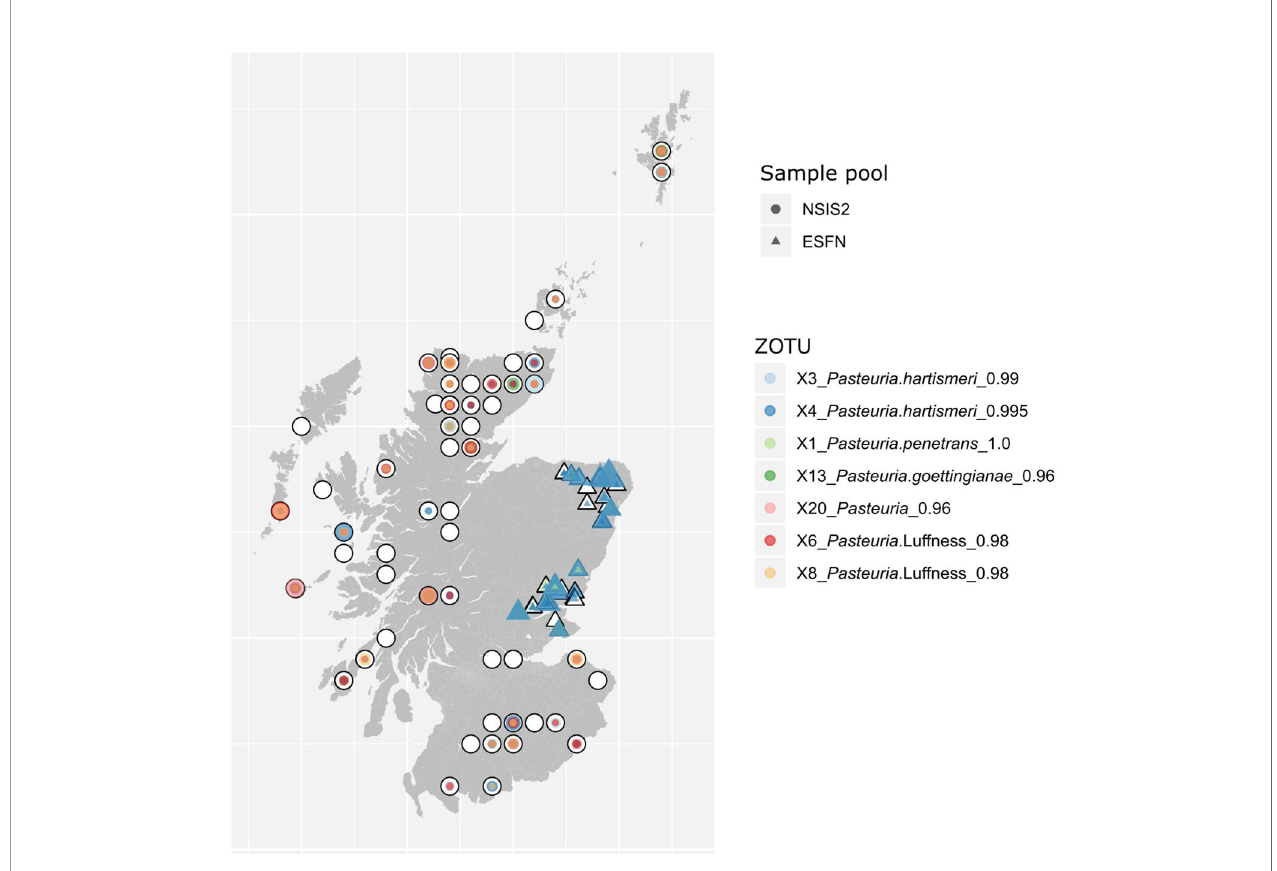
FIGURE 3 | Map of distribution of the most abundant Pasteuria spp. ZOTUs across both NSIS2 (circles) and ESFN (triangles) datasets. Plot points are colored by ZOTU and sized as a function of the total number of merged read pairs recovered for that ZOTU µl − 1 of product added to the fi nal pool from the corresponding ( Figure 2 ). Reads obtained from sequencing μl − 1 of PCR product do not increase beyond 1,000,000 target gene copies in the PCR reaction.